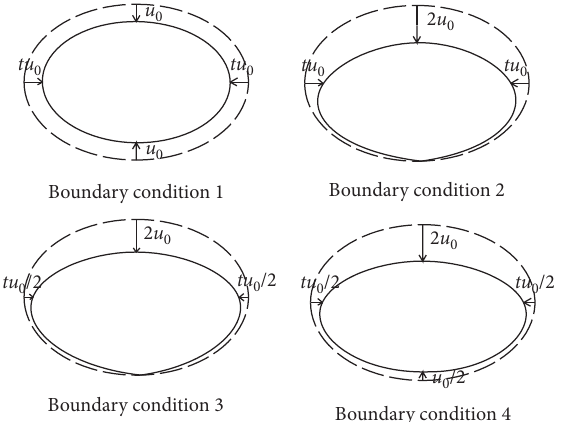
Figure 3: Boundary conditions of the given